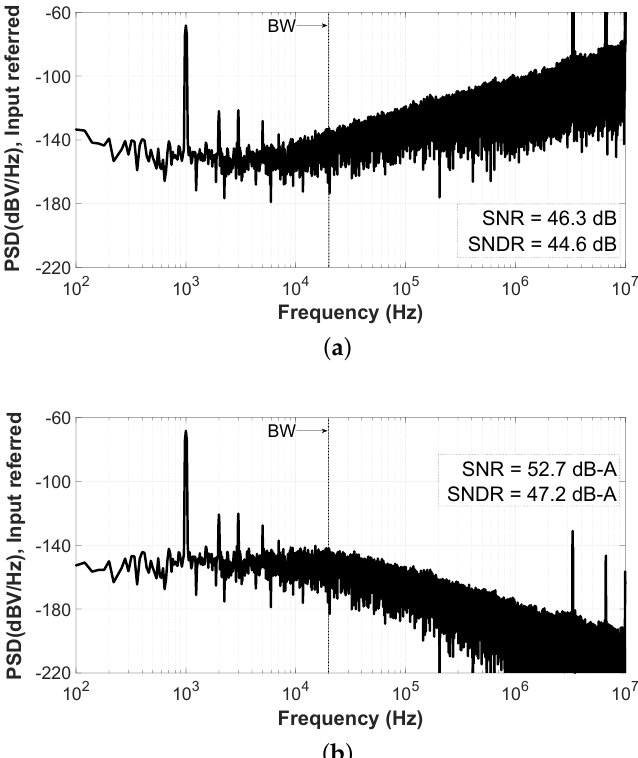
Figure 17. Measured spectrum for an acoustic tone of 94 dB SPL at 1 kHz: ( a ) Non-A-Weighted; ( b )